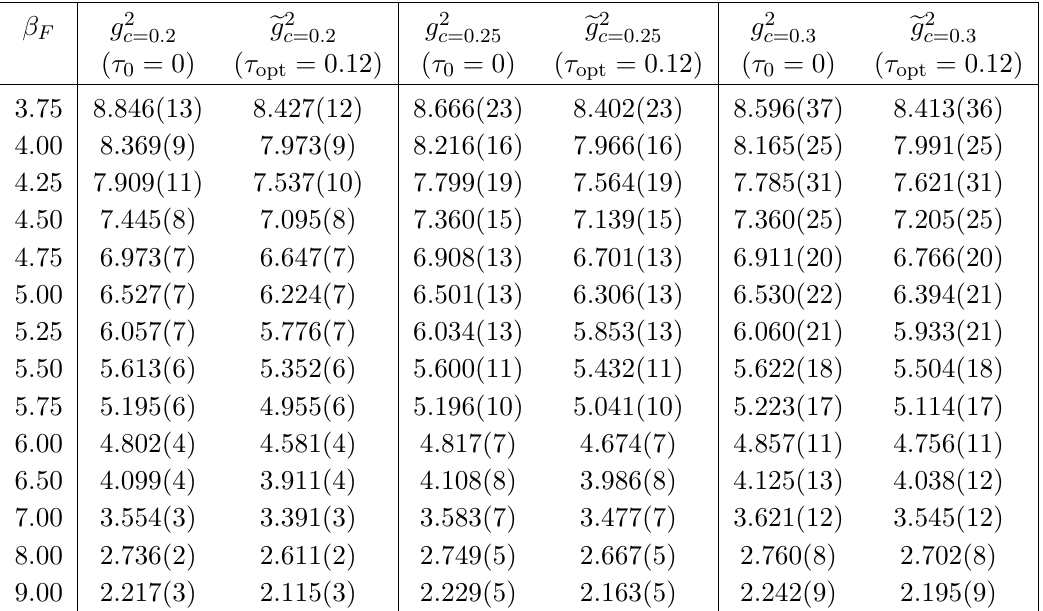
Table 21 . Renormalized gradient (cid:13)ow couplings based on the plaquette discretization of E ( t ) for the 32 4 lattice ensembles used in this work, with columns as in table 15.